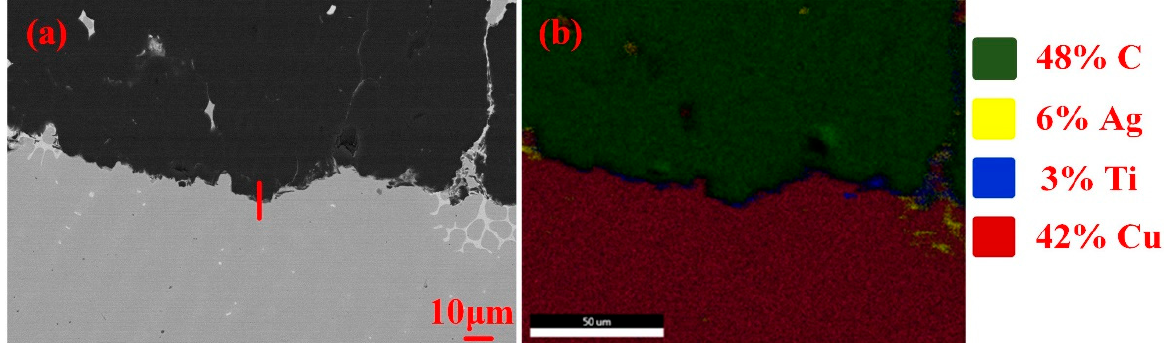
Figure 7. ( a ) the interfacial structure of the welded joints with 4.5 wt.% Ti, ( b ) the relevant element mapping image in ( a ). Table 3. EDS results of marked points in Figure 9 (at.%).